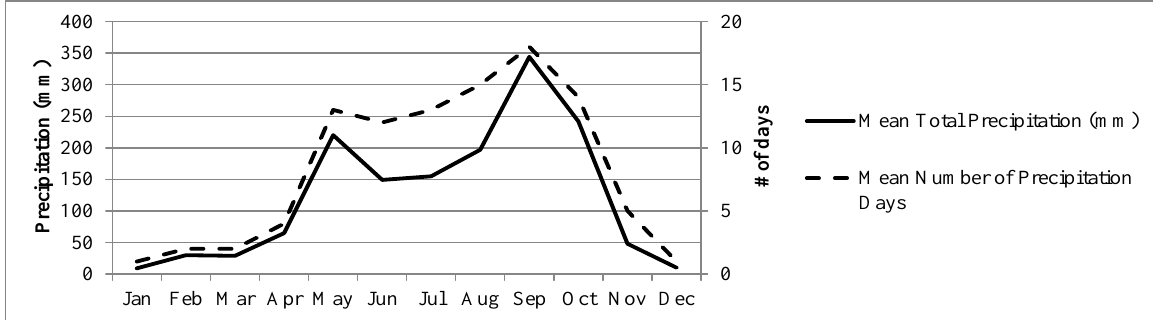
Figure 6. Precipitation in Bangkok based on monthly averages for the 30-year period